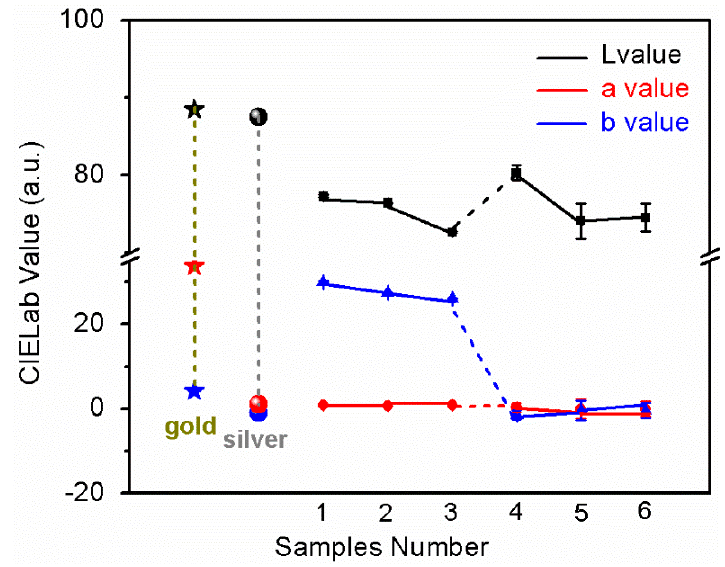
Figure 1. The L, a, and b value of gold, silver and prepared samples.